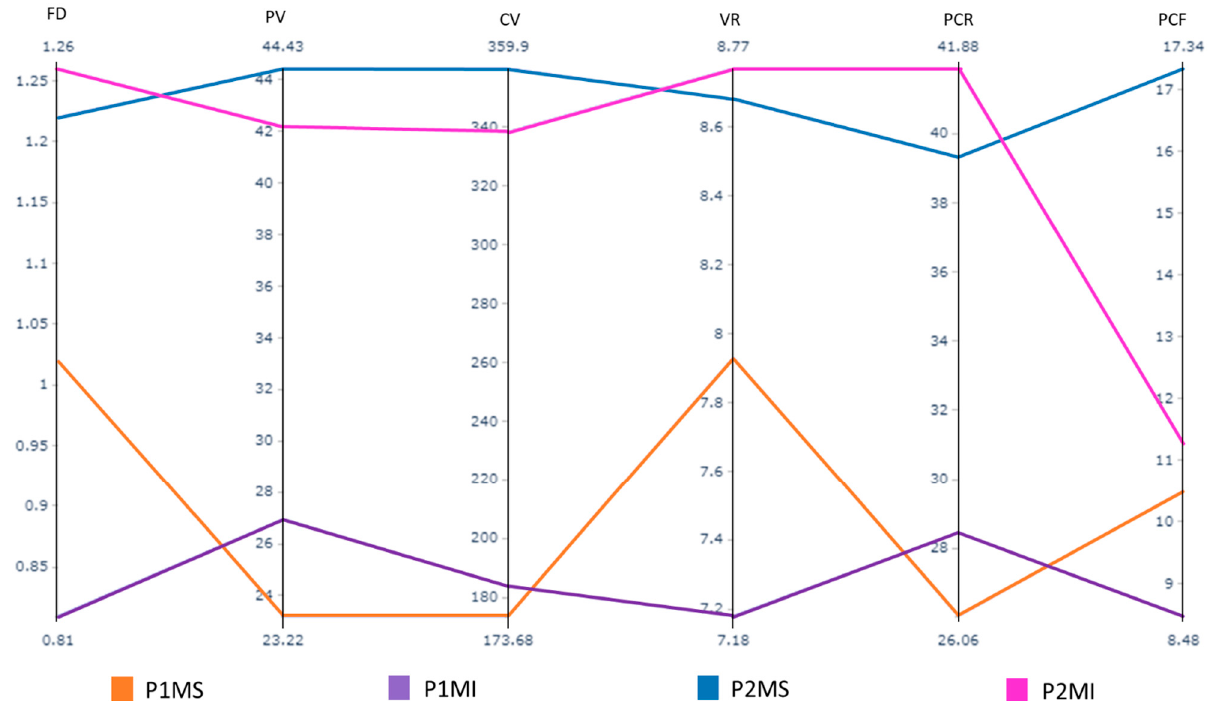
Figure 6. Parallel coordinates plot of study’s variables in which the means of each variable can be compared graphically. Pulp chamber roof (PCR); pulp chamber floor (PCF); distance between pulp chamber floor and furcation (FD); pulp chamber volume (PV); dental crown volume (CV); volume ratio (VR); primary maxillary first molar (P1MS); primary mandibular first molar (P1MI); primary maxillary second molar (P2MS); and primary mandibular second molar (P2MI). A statistically significant difference was observed between the four groups and related study variables using the Kruskal–Wallis test for each measurement performed (Table 1).